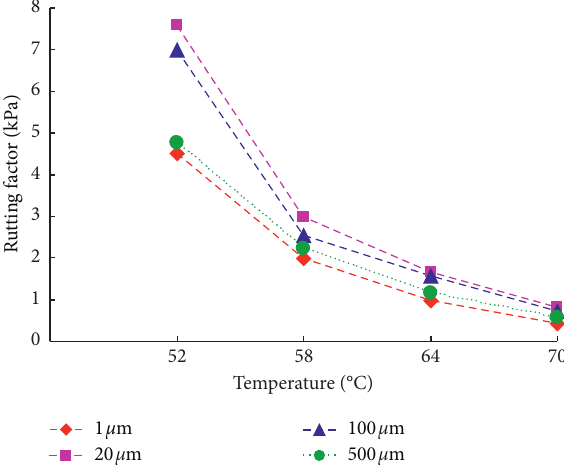
Figure 13: Rutting factor of different nano-SiC particle size.